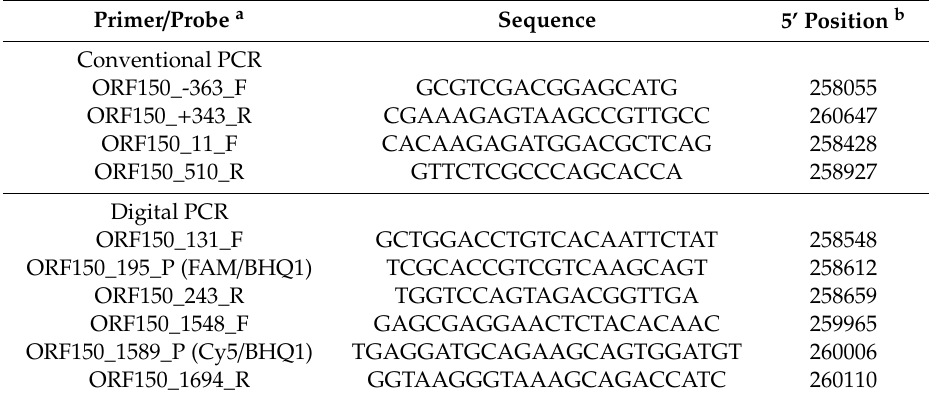
Table 1. List of primers and probes used for conventional and digital PCR. Primer / Probe a Sequence 5’ Position